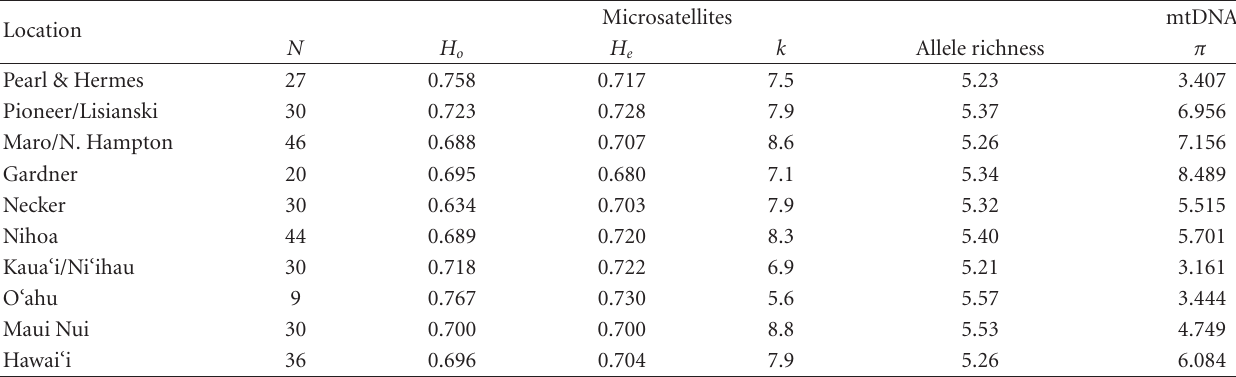
Table 2: Number of specimens ( N ) collected from each location and diversity statistics for microsatellites and mitochondrial DNA (mtDNA) control region: H o : observed heterozygosity; H e : expected heterozygosity; k : average number of alleles; π : nucleotide diversity. MtDNA data is from Rivera et al. [25].